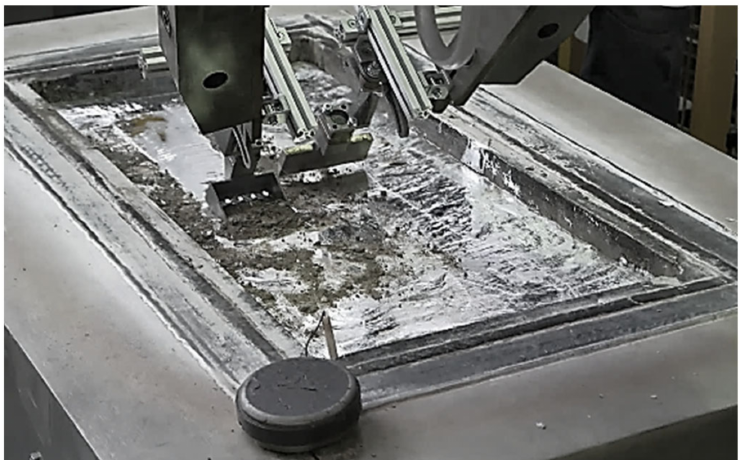
Figure 10. Automated extraction system designed as an extraction shovel provided with elongated drainage